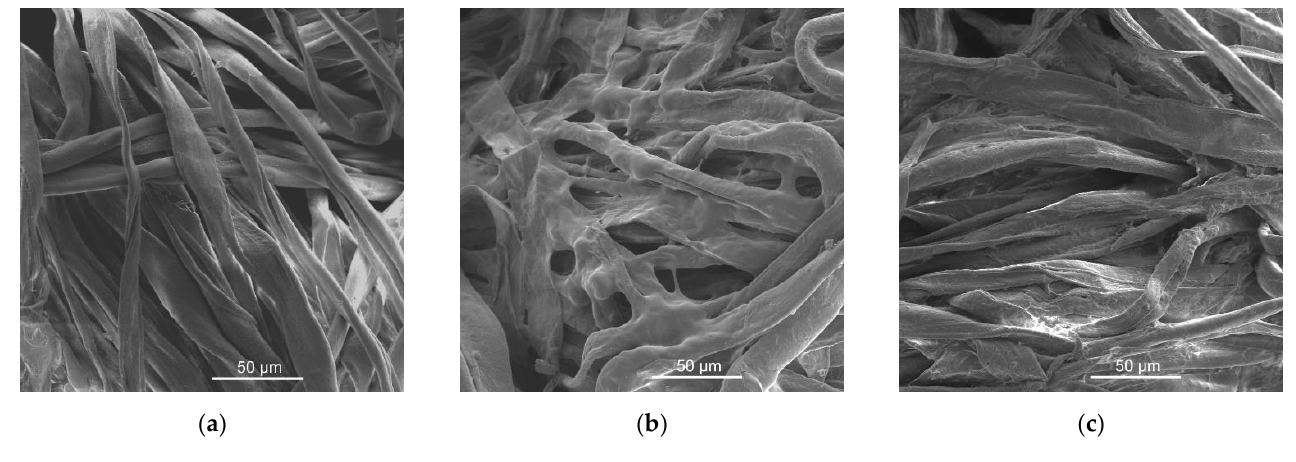
Figure 7. SEM images of cotton: ( a ) untreated; ( b ) 8 BL; ( c ) 8 BL + Cu. All the post-burn charred LbL samples shown in Figure 8 demonstrate a bubbled structure, one that is typical for intumescent flame-retardant systems with phytic acid acting as an acid donor, chitosan as a carbon donor, and urea as a blowing agent generating non-flammable gases. Cu 2+ metal ions act as a shield that is capable of preventing heat from going into the fiber [33,34]. There is no difference between the post- burnt char of a sample treated with PA/CH-urea and PA/CH-urea + Cu 2+ ions.